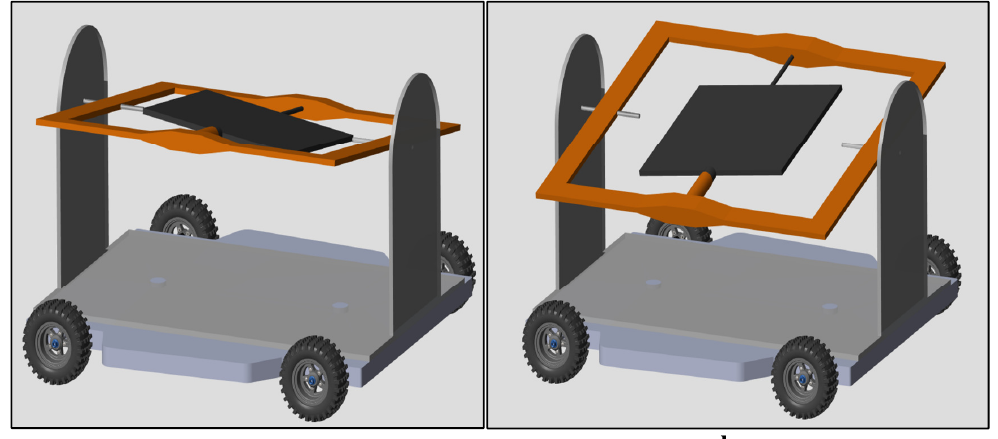
a b Fig. 16. Self-balancing of the (platform on the mobile car) structure in the virtual simulation a) under tilt angle (10° on positive X-axis and 10° on positive Y-axis) b) under tilt angle (-10° on negative X-axis and -10° on negative